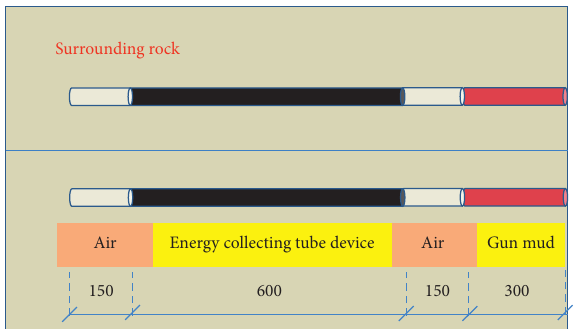
Figure 13: Schematic diagram of no gun mud-shaped charge